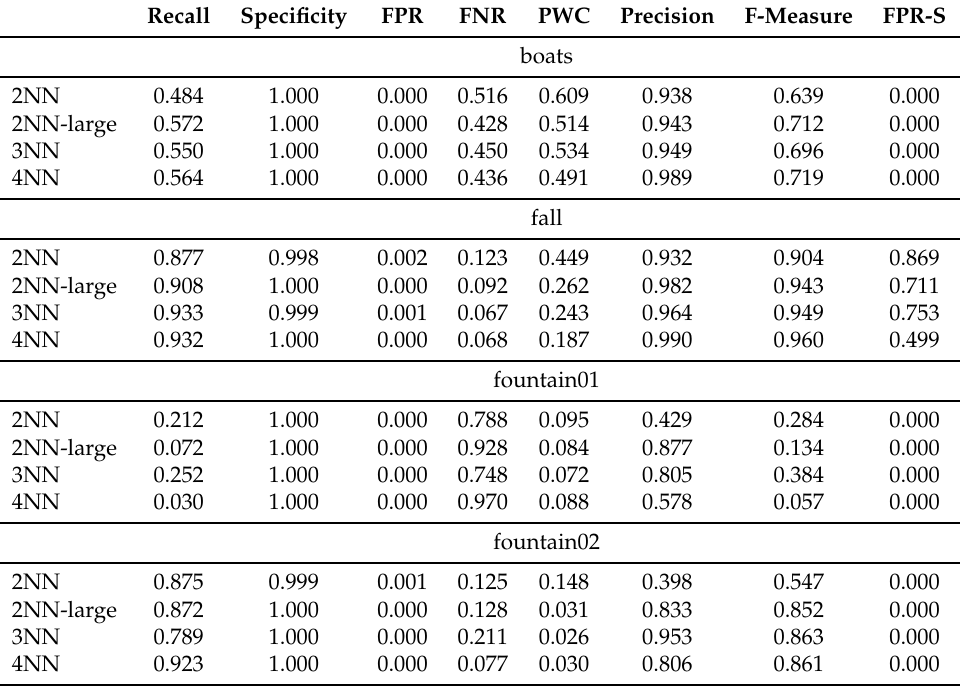
Table 3. Performance results of four networks on four sequences of the dynamic background category in the CD2014 dataset [7]. FPR, FPR-S, FNR, and PWC denoted false positive rate, FPR in only shadows, false negative rate, and percentage of wrong classifications,